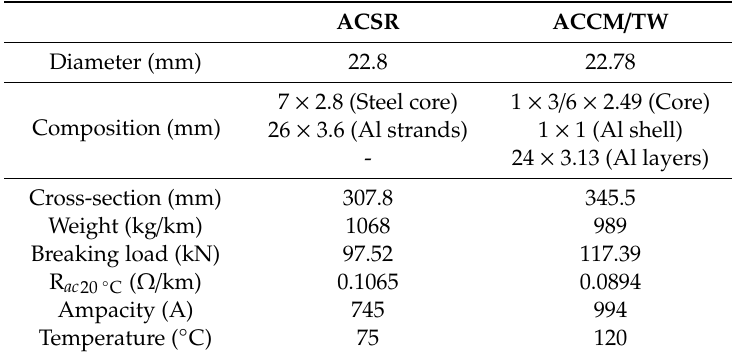
Figure 2. Section of the innovative ACCM / TW conductor with diameter 22.78 mm. Table 6. Main properties of the innovative conductor for transmission OHLs compared with its reference traditional conductor.